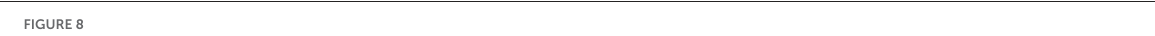
FIGURE8 dorsal, and (J) ventral LC. (K–M) Quantification of the number of CC3 + /GFAP + cells in the (K) global, (L) dorsal, and (M) ventral LC. The data are presented as the mean ± SEM of the number of the CC3 + cells/ µ m 2 obtained from three to four quadrants per section (three slices). * p < 0.05, ** p < 0.01, *** p < 0.001 vs. the group indicated, one-way ANOVA followed by a Tukey’s